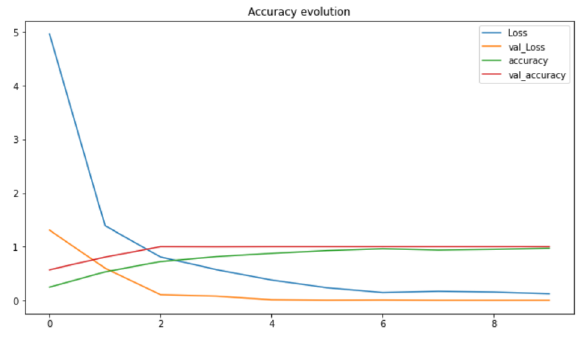
Figure 6. Accuracy